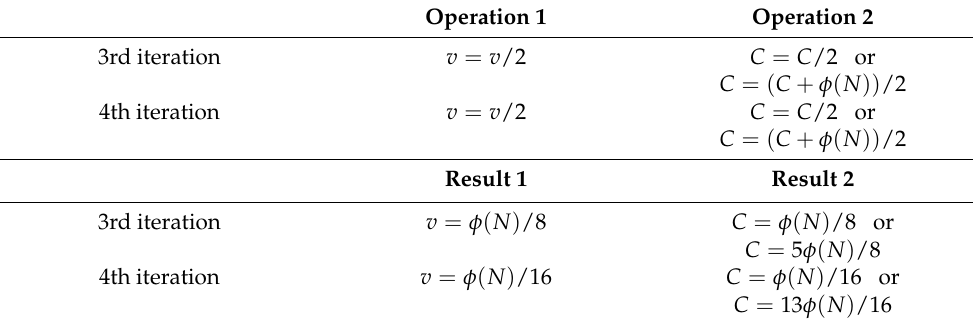
Table 2. Target operations on BEEA ( e , φ ( N ) ) after 2nd